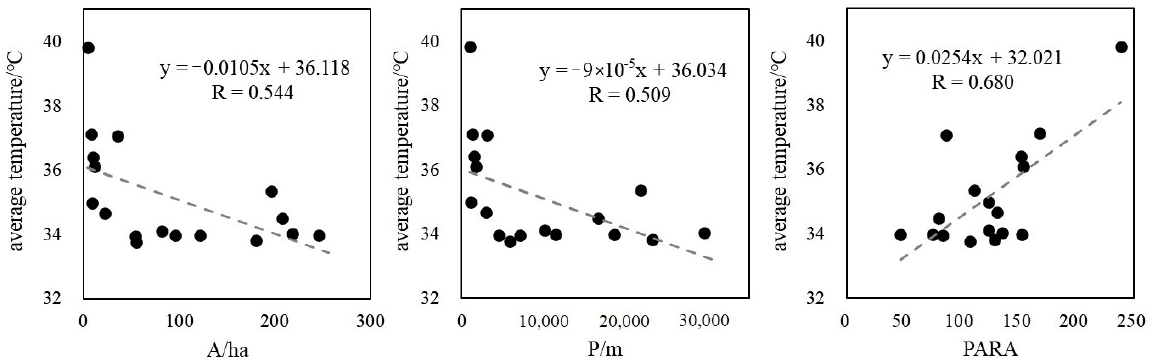
Figure 6. Relationship between average temperature and landscape pattern metrics of typical urban parks.